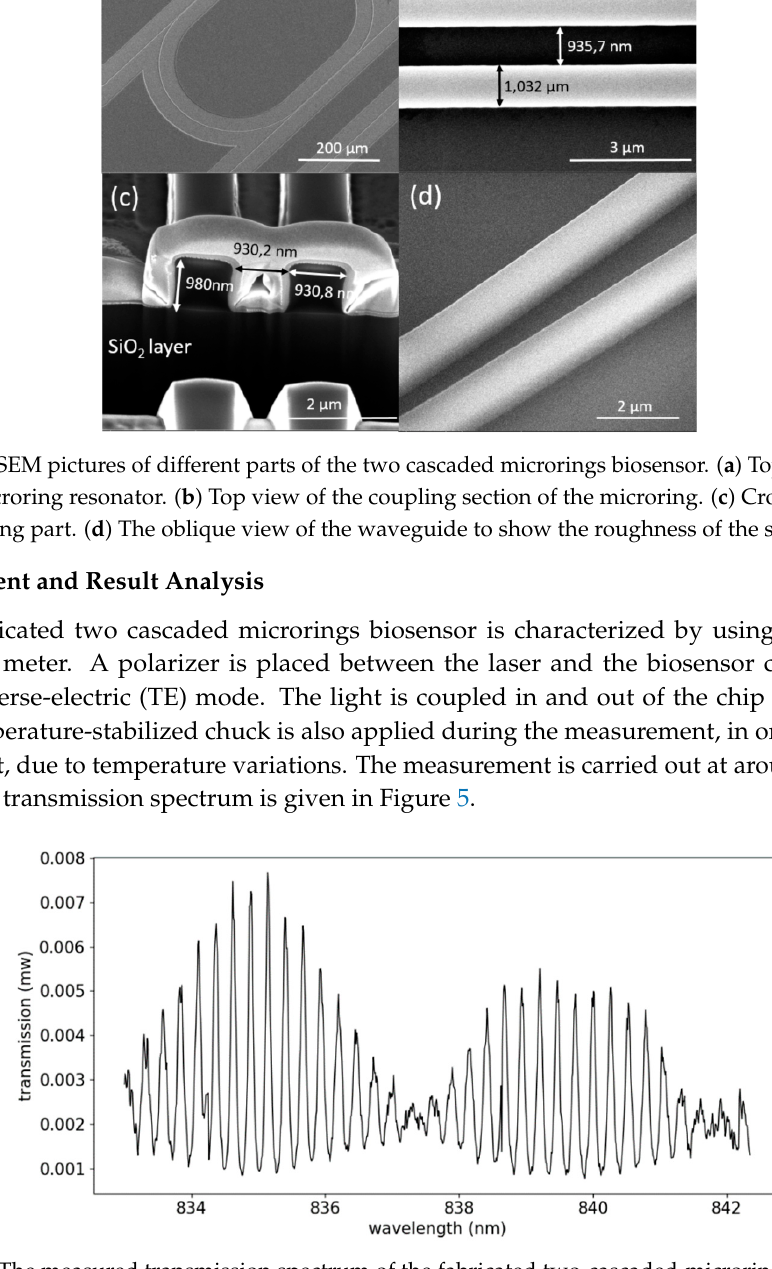
Figure 5. The measured transmission spectrum of the fabricated two-cascaded-microrings biosensor.